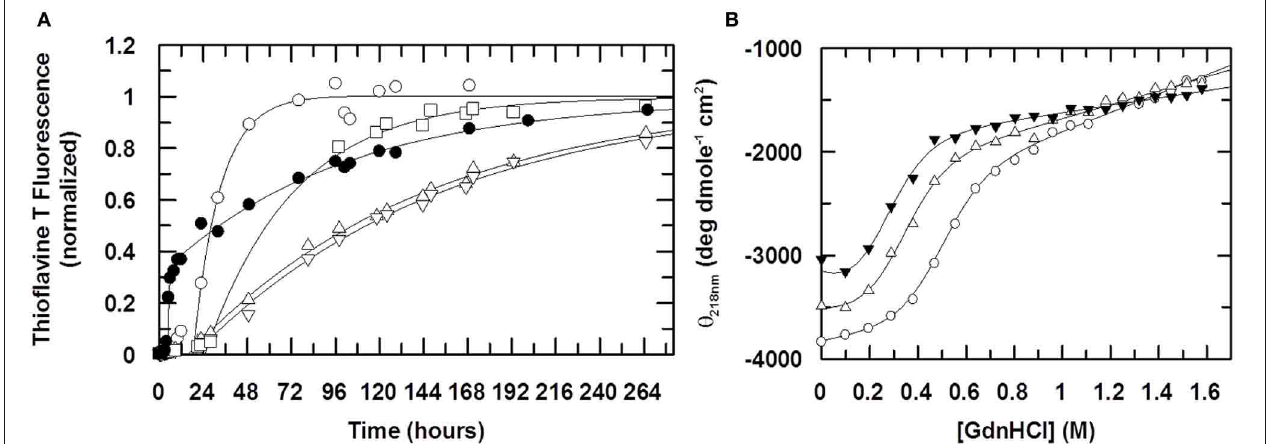
FIGURE 5 | The effect of Cu (II) on fibril formation. In (A) the formation of stefin B fibrils is monitored using Thioflavine T fluorescence at 482nm ( λ excitation = 442nm). The ratio of Cu (II) to protein is 0:1 (open circles), 0.5:1 (open squares), 1:1 (open triangles, up) and 2:1 (open triangles, down). The fibrillization of the mutant stefin B V59Q, where the equivalent point mutation to that seen in the amyloid disease-causing homolog, cystatin C (L68Q) is shown for comparison (closed circles). Solid lines represent data fitting to a single exponential increase. Elongation rate constants k e are 1 . 9 × 10 − 5 s − 1 in the absence of Cu (II) and 2 . 5 × 10 − 6 s − 1 in the presence of saturating amounts. For the mutant V59Q (closed circles), the lag time is reduced 5-fold